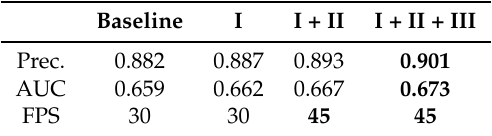
Table 2. Ablation results of the FAF on the OTB100, which shows the effectiveness of each component of the proposed method. The best results are in